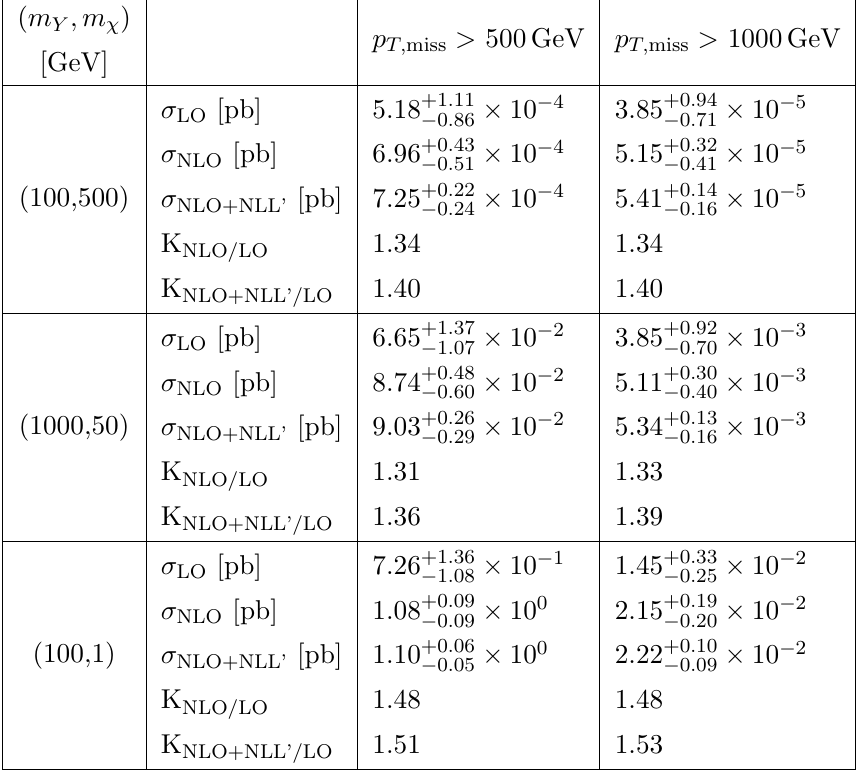
Table 1 . Integrated cross section for a given cut on p T; miss for our benchmark points at di(cid:11)erent levels of theoretical accuracy and the corresponding K-factors. The stated errors are determined by the 7-point scale variation de(cid:12)ned in